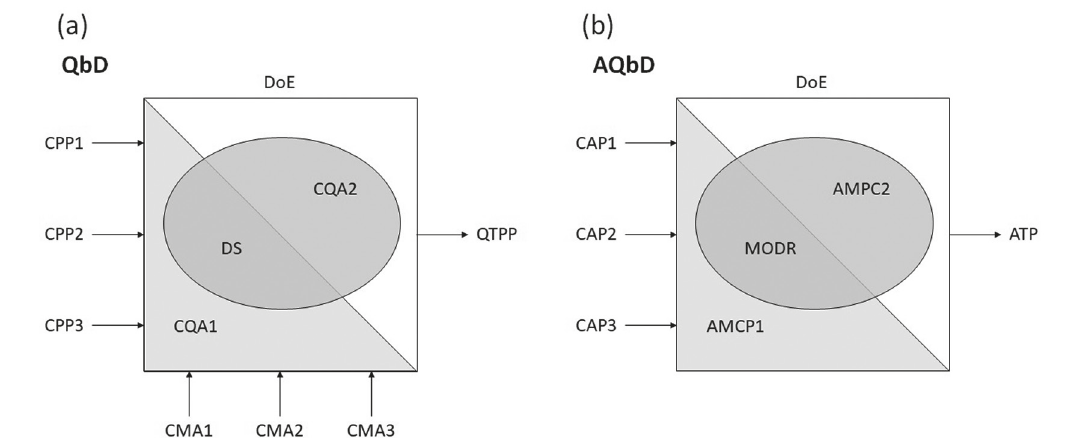
FIGURE 1 – Schematic diagram of the steps for implementation of pharmaceutical QbD (a) and analytical QbD (b). Legend: CPP = Critical Process Parameter, CMA = Critical Material Attribute, CQA = Critical Quality Attribute, DS = Design Space, QTPP = Quality Target Product Profile, CAP = Critical Analytical Parameter, AMPC = Analytical Method Performance Characteristic, and ATP = Analytical Target